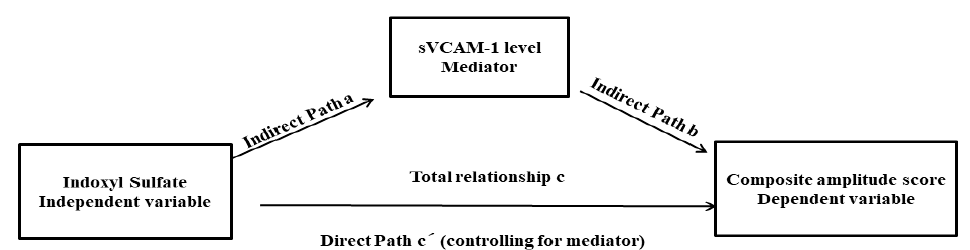
Figure 1. The diagram of the mediation hypothesis